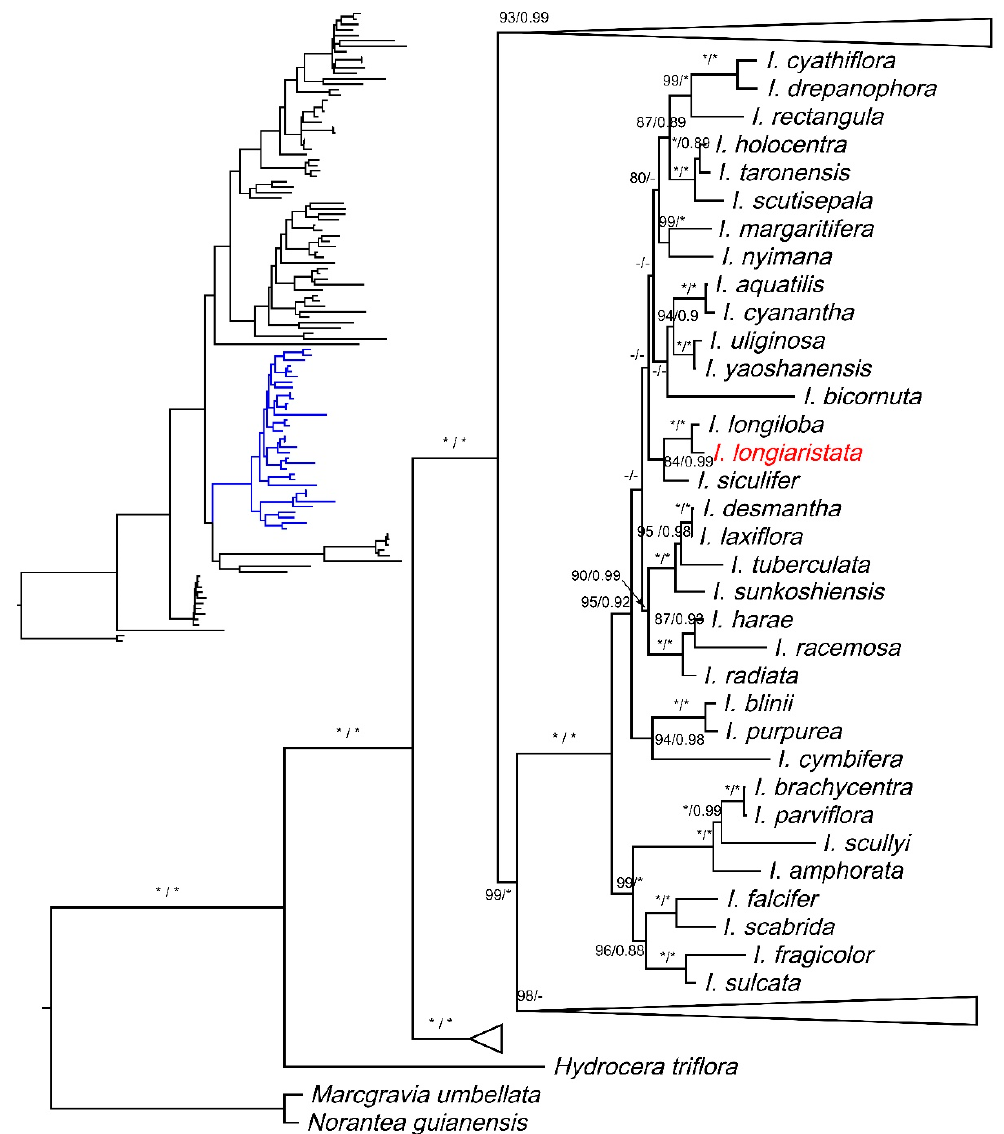
Figure 2. Phylogenetic tree based on a combined dataset of nrITS and plastid atpB-rbcL DNA sequences. The bootstrap percentages (BP) for maximum likelihood (ML) and posterior probabilities (PP) of Bayesian inference (BI) are shown in the branch (BP/PP, the dash [ ‐ ] indicates BP < 80 or PP < 0.80 at a node, and the asterisk [*] indicates BP = 100 or PP = 1.00). Only the ML tree is shown, because its topology is nearly identical to the BI tree. Impatiens longiaristata is highlighted in red.